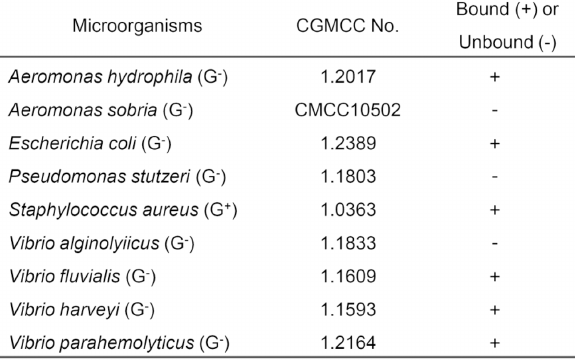
Figure 2. Binding activity of recombinant Sp-SPH protein to different bacteria. The recombinant Sp-SPH protein was incubated with formaldehyde-fixed bacteria. After incubation, the supernatants were separated by centrifugation. The pellets were then washed with PBS and the bound proteins were eluted with SDS-PAGE loading buffer followed by electrophoresis. (A) All eluted samples were examined by Western blot analysis under reducing condition with the employment of the anti-His antibody. –s: bacterium + Sp-SPH protein; -p: bacterium + PBS. (B) Summery of binding affinity of Sp-SPH protein to the bacteria selected.